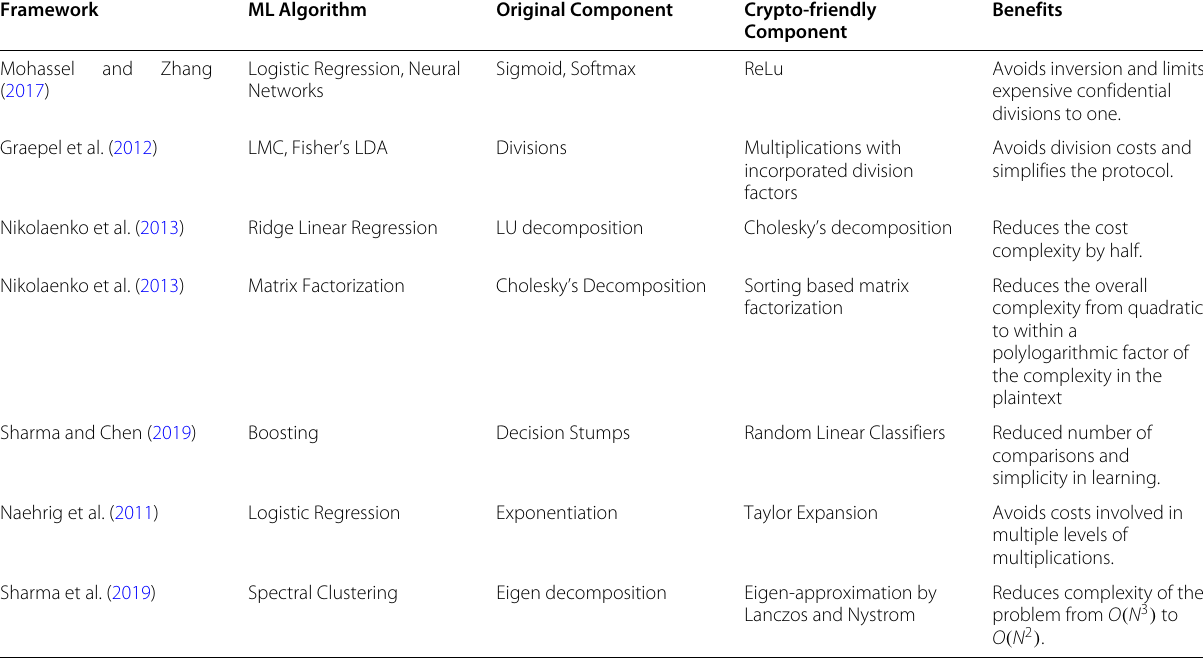
Table 3 Example CML methods that replace the expensive algorithmic components with their crypto-friendly versions